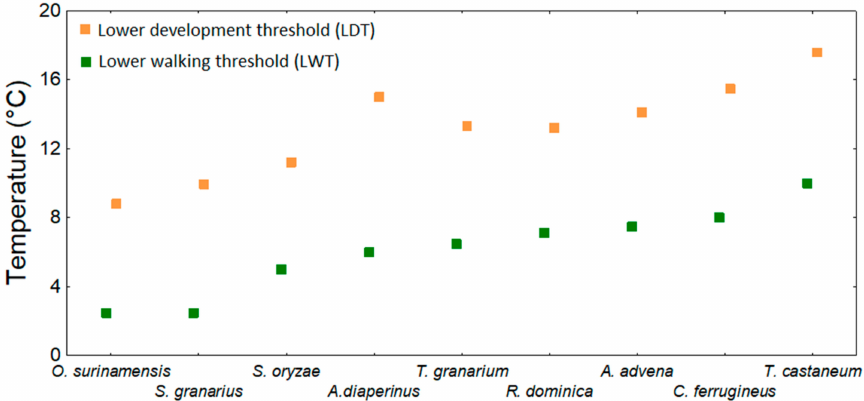
Figure 4. Comparison of lower walking (LWT) and development thresholds (LDT) of stored-product beetles for which both variables are available. (The lowest LDT value from Tables 2 and 3 was used for each